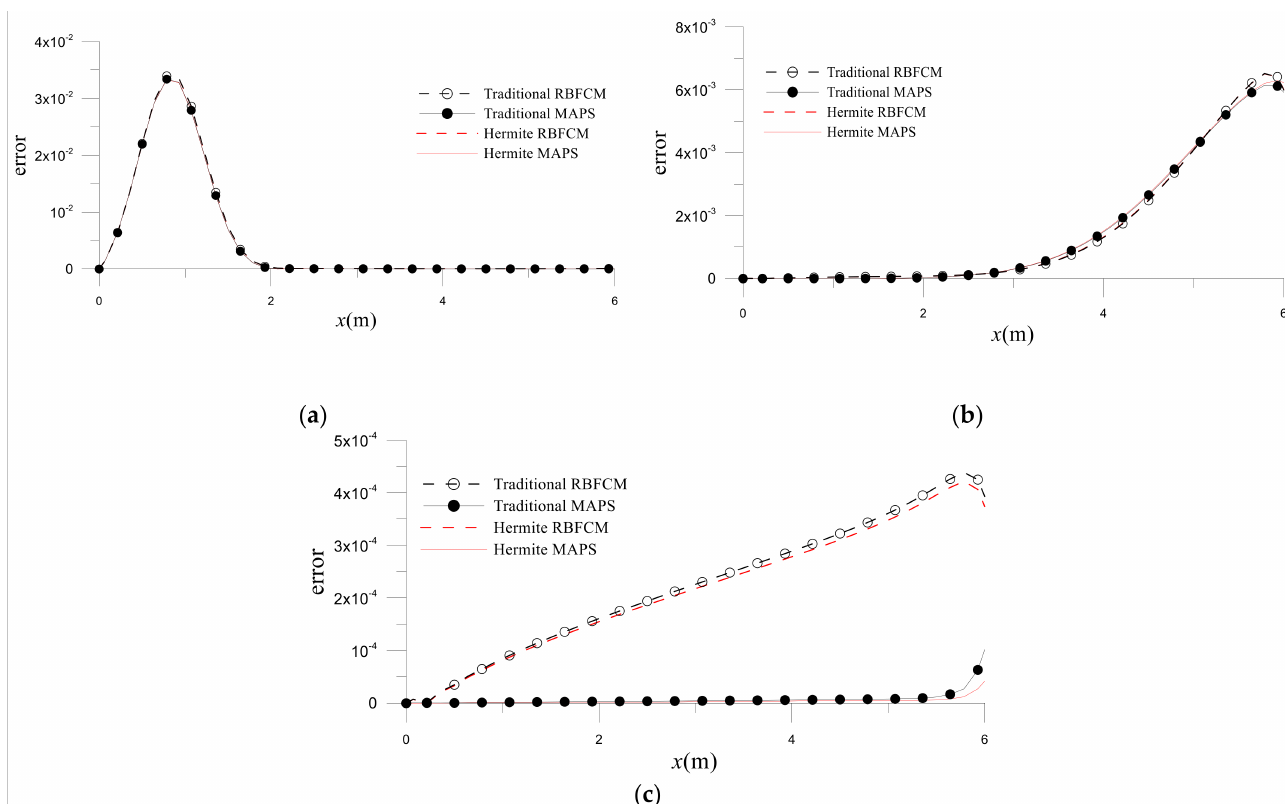
Figure 14. Errors of numerical solutions obtained by the four methods at ( a ) t = 0.1, ( b ) t = 1 and ( c ) t = 2 for Example 3.